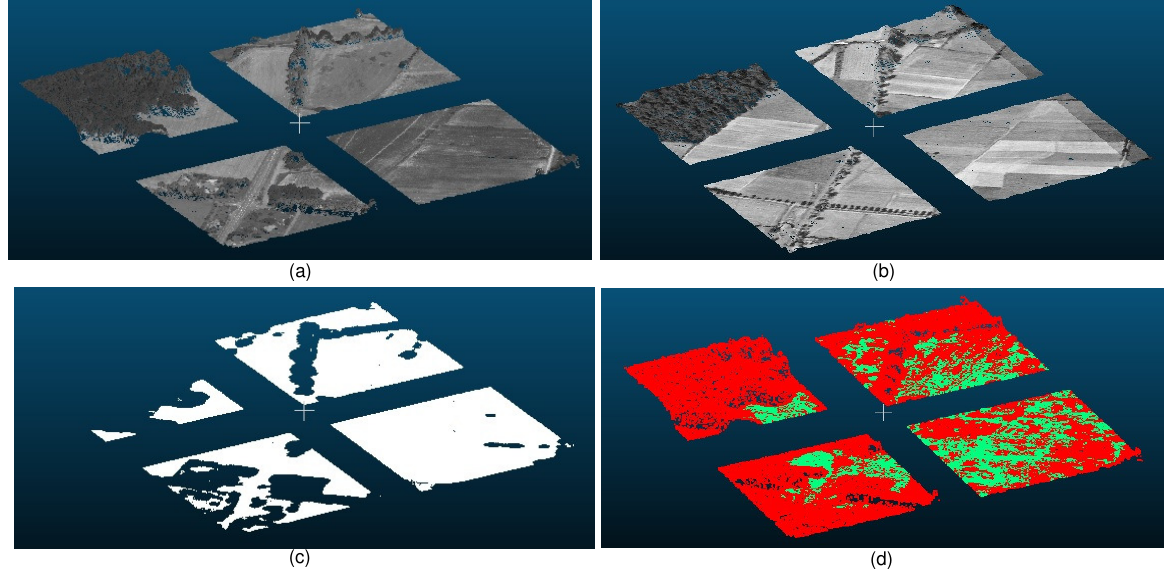
Figure 4. Experimental results obtained on the dataset Fabas. Figures (a), (b): N = 4 homologous 3D patch matches, Figure (a) P 3 D i = 1 , .., N : reference (recent) 3D point cloud, (b) P 3 D , i = 1 , .., N : historical 3D point cloud; total overlap: n = 285962 new,i , old,i points; Figure (c): the result of the curvature-based ground filtering procedure obtained by running the algorithm on the reference (recent) 3D point cloud illustrated in Figure(a), P 3 D new,i , i = 1 , .., N ; before ground extraction: n = 285962 3D points; ground filtering parameter δ = 0 . 3 ; after ground extraction: n G = 122517 3D points representing the ground, i.e. 42 . 8% of the total amount of homologous points; Figure(d): superposed registered 3D point clouds: red color - reference (recent) DSM, green color - historical DSM. 3D patch